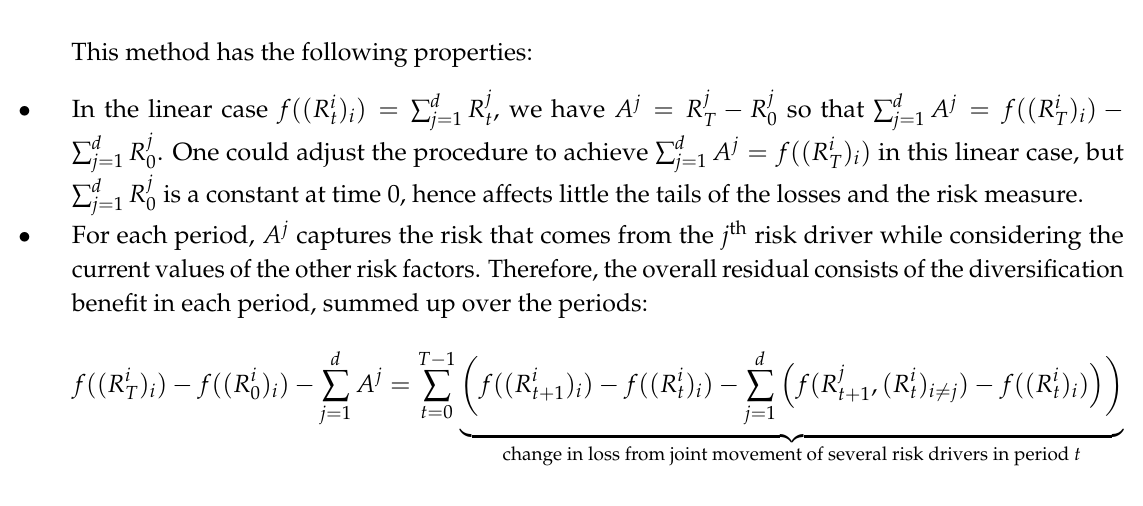
change in loss from joint movement of several risk drivers in period